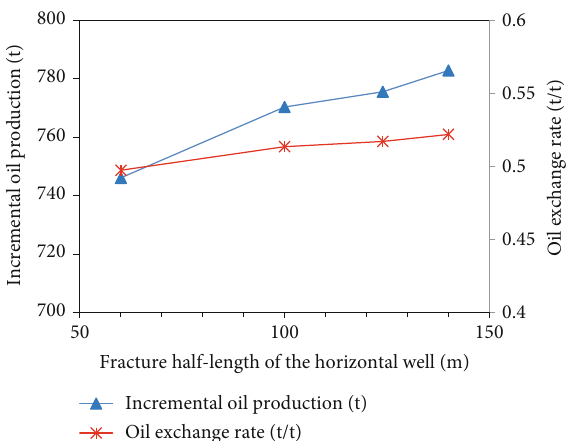
Figure 9: Oil exchange rate and incremental oil recovery through CO hu ff -n-pu ff under di ff erent reservoir thickness. 2